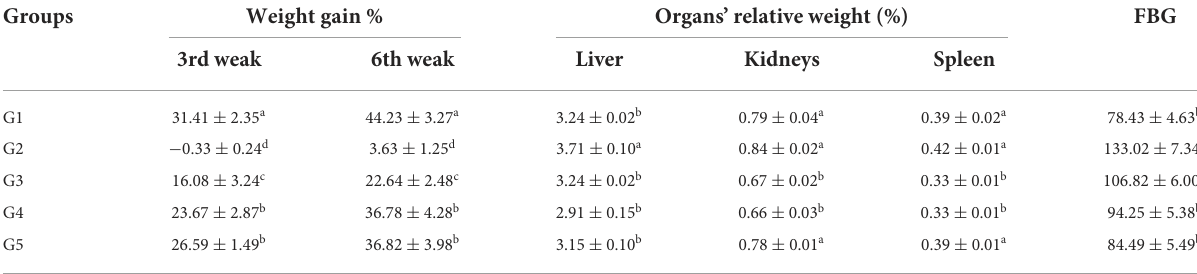
TABLE 3 Effect of L. culinaris sprouts hydroalcoholic extract on weight gain%, organs’ weight, and FBG in CCl 4 -induced oxidative stress and hepatotoxicity in rats (mean ± SE), n = 8. Groups Weight gain %